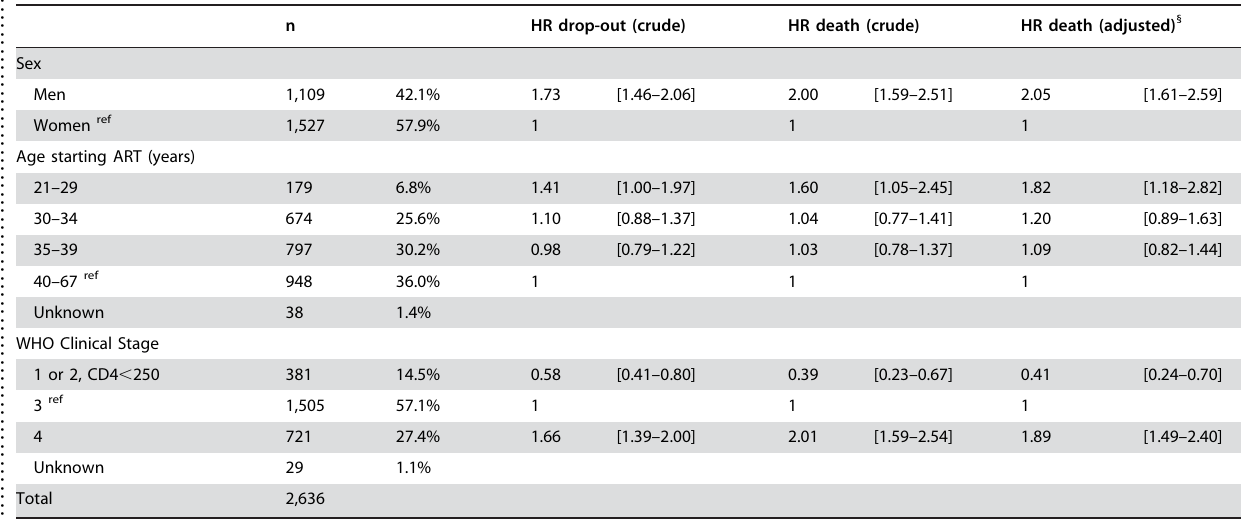
Table 1. Distribution of age, sex and clinical stage of teachers at ART initiation and association with program drop-out (death, ART